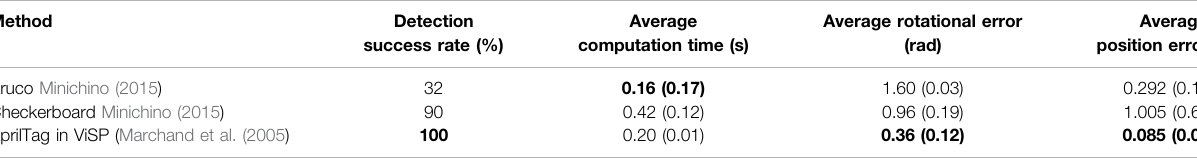
TABLE 2 | Marker comparison for 6D pose estimation. Method